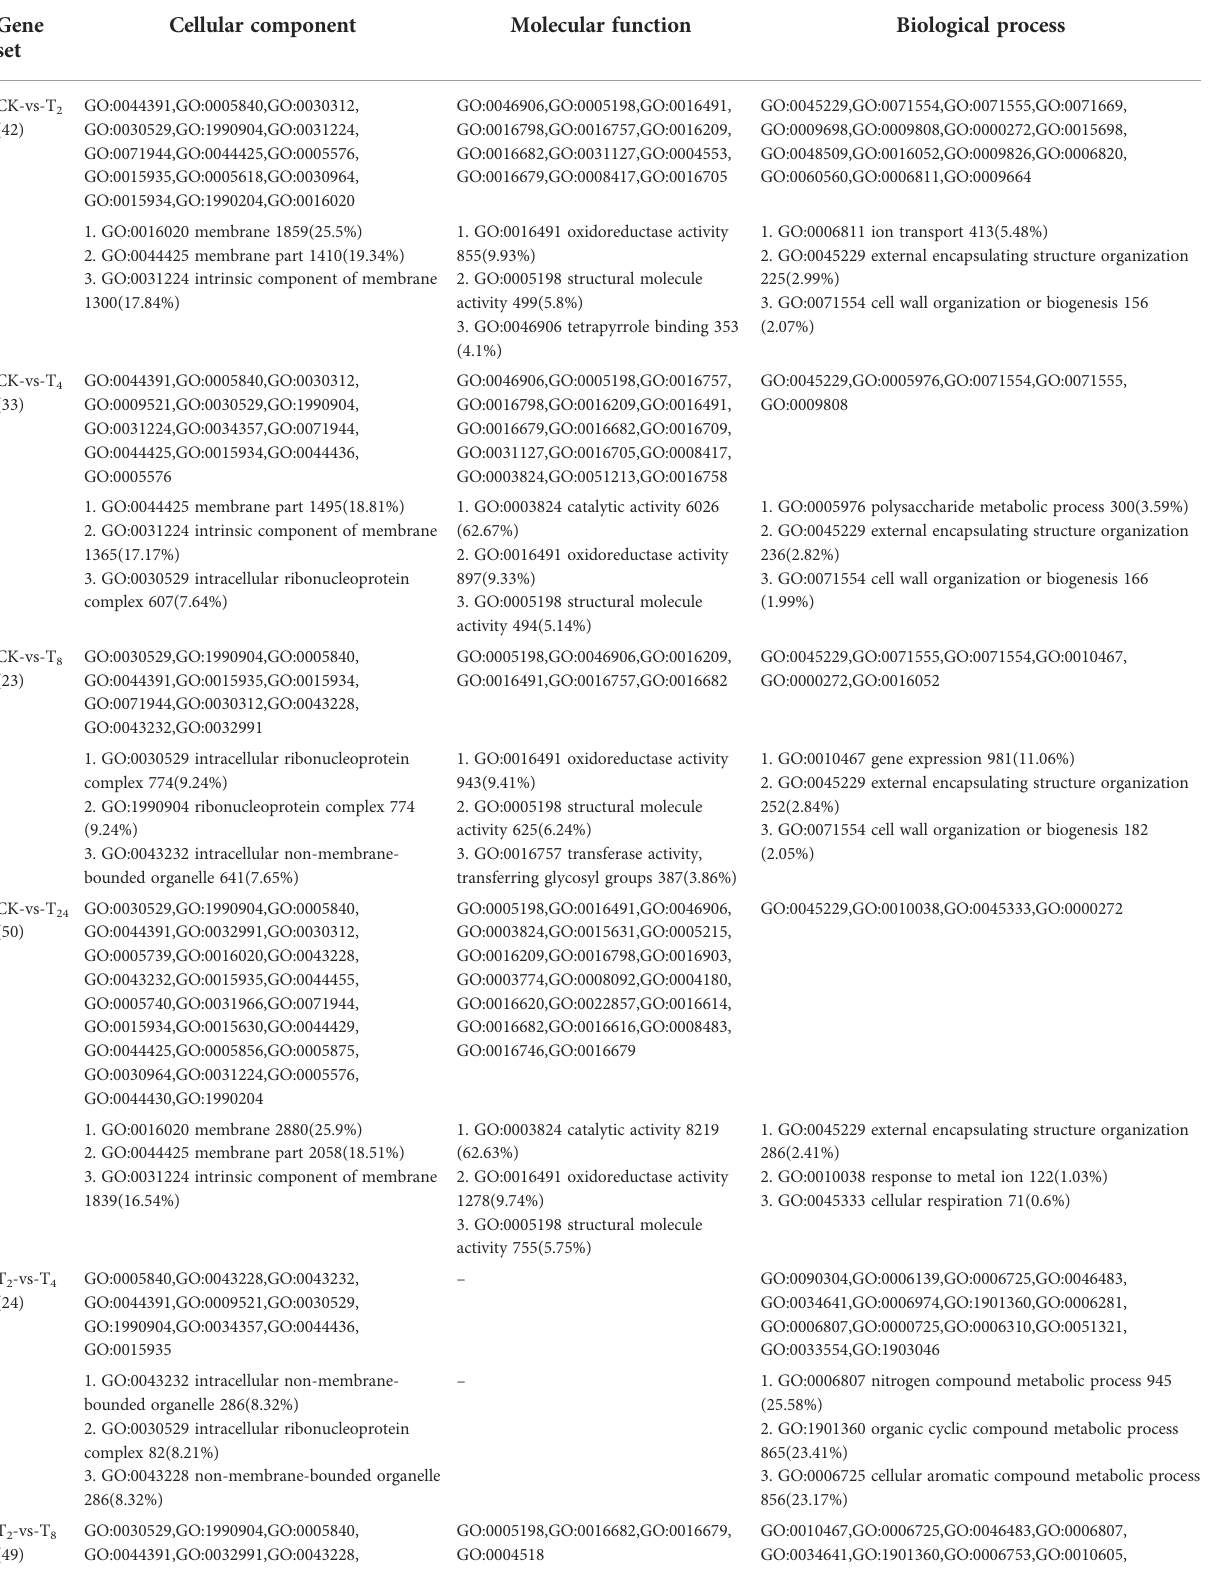
TABLE 4 Signi fi cant GO and top three enriched genes in different gene sets. Gene